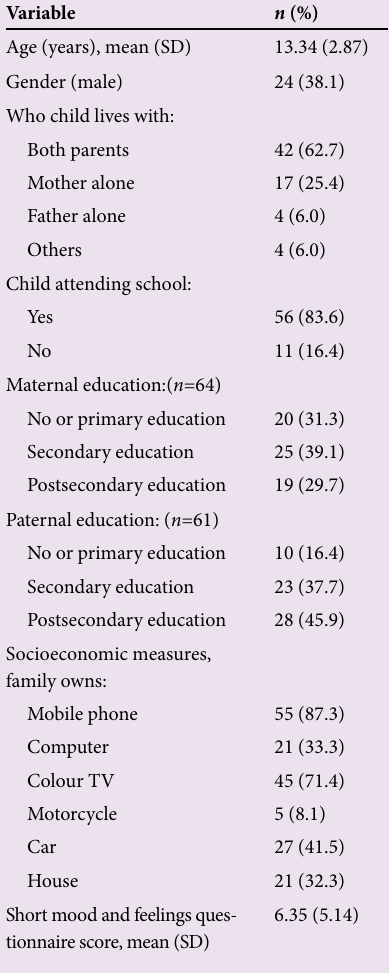
Table 1. Sociodemographic and family